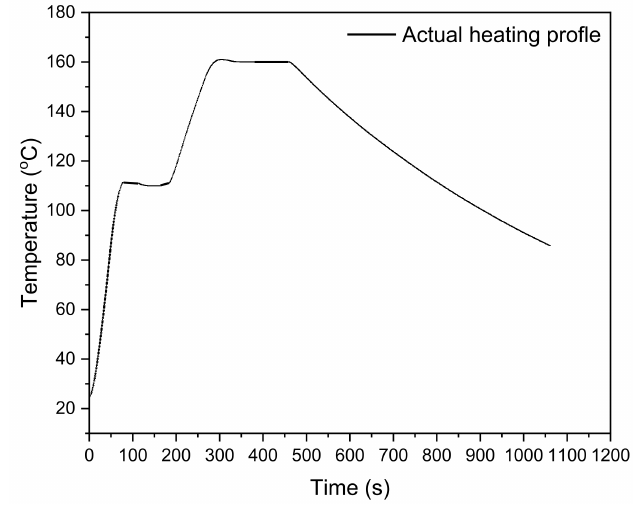
Figure 1. Heating profile of the reflow